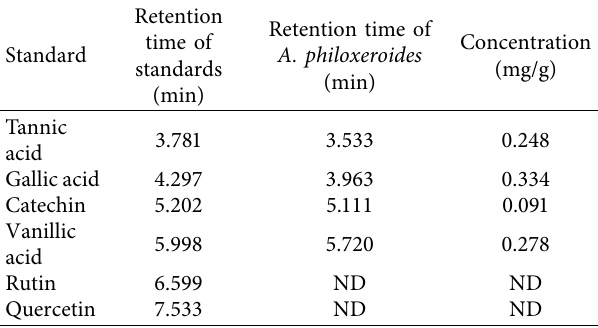
Table 2: Phenolic acids identified in Alternanthera philoxeroides